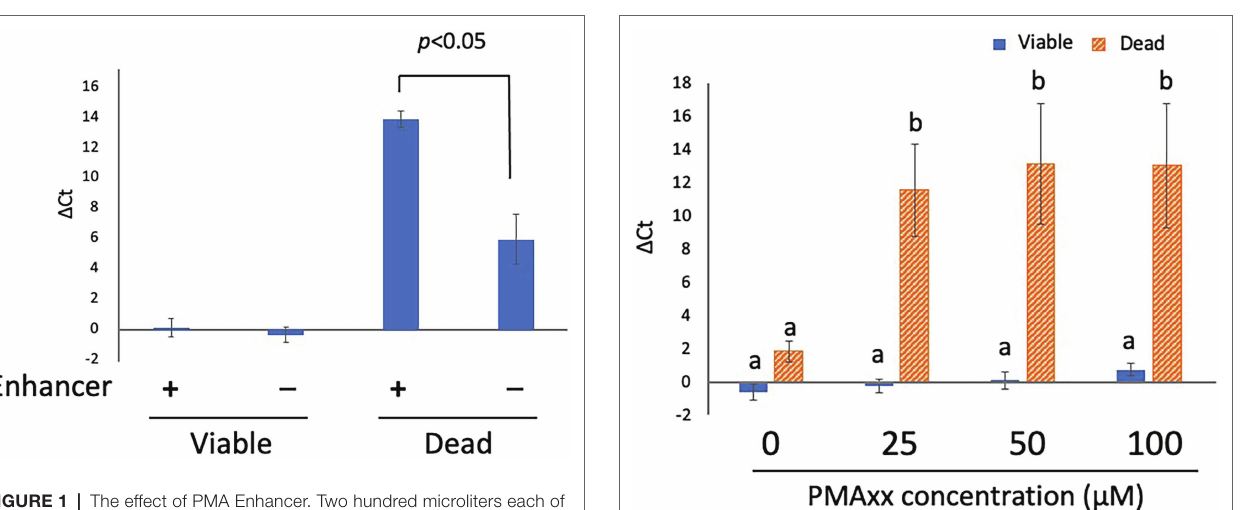
FIGURE 1 | The effect of PMA Enhancer. Two hundred microliters each of viable and dead cell suspensions (concentration: 5 × 10 7 CFU/ml for both) was treated with PMA Enhancer or Brucella broth, and 25 μ M PMAxx was added prior to DNA extraction and qPCR. The columns display mean values from three independent experiments ± standard deviation. PMA, propidium monoazide; CFU, colony-forming unit; and qPCR, quantitative PCR.